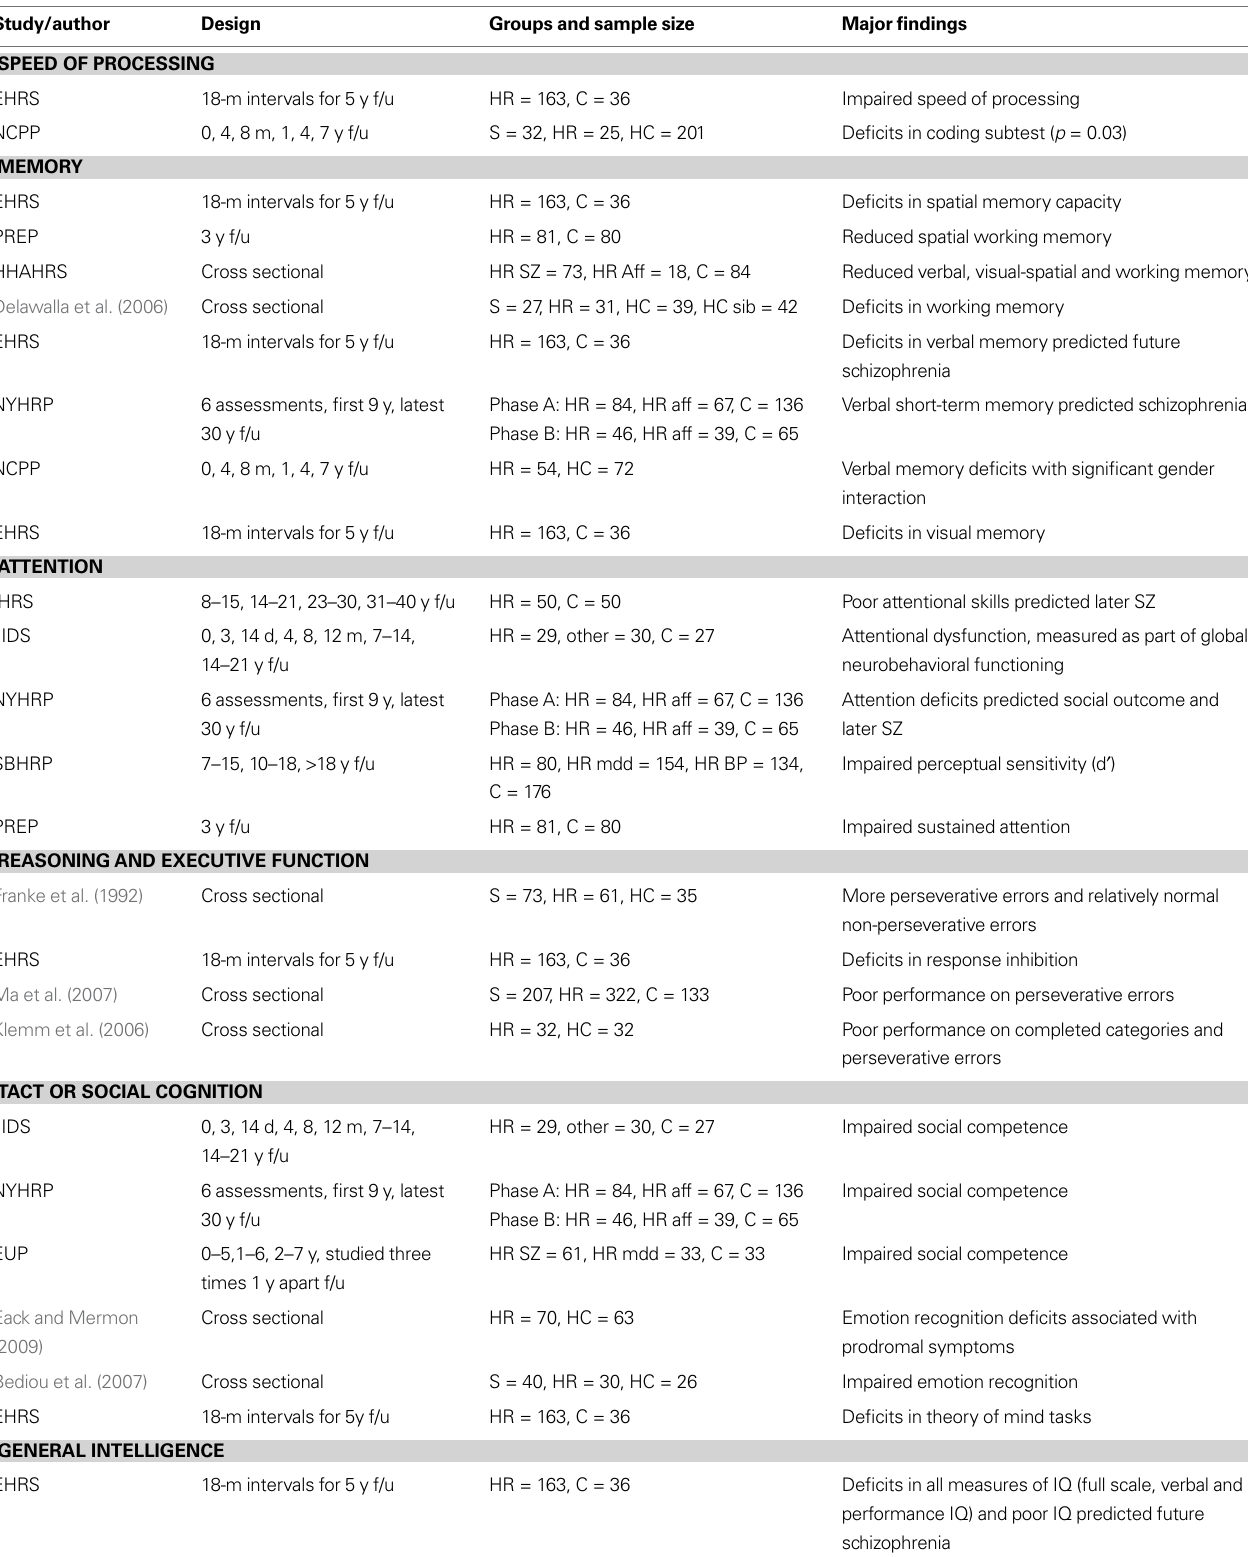
Table 1 | Findings in cognitive domains in high-risk